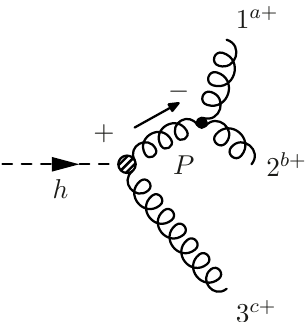
Figure 1. Factorization of the + + + amplitude on s 12 . The direction of the arrow indicates the direction of momentum